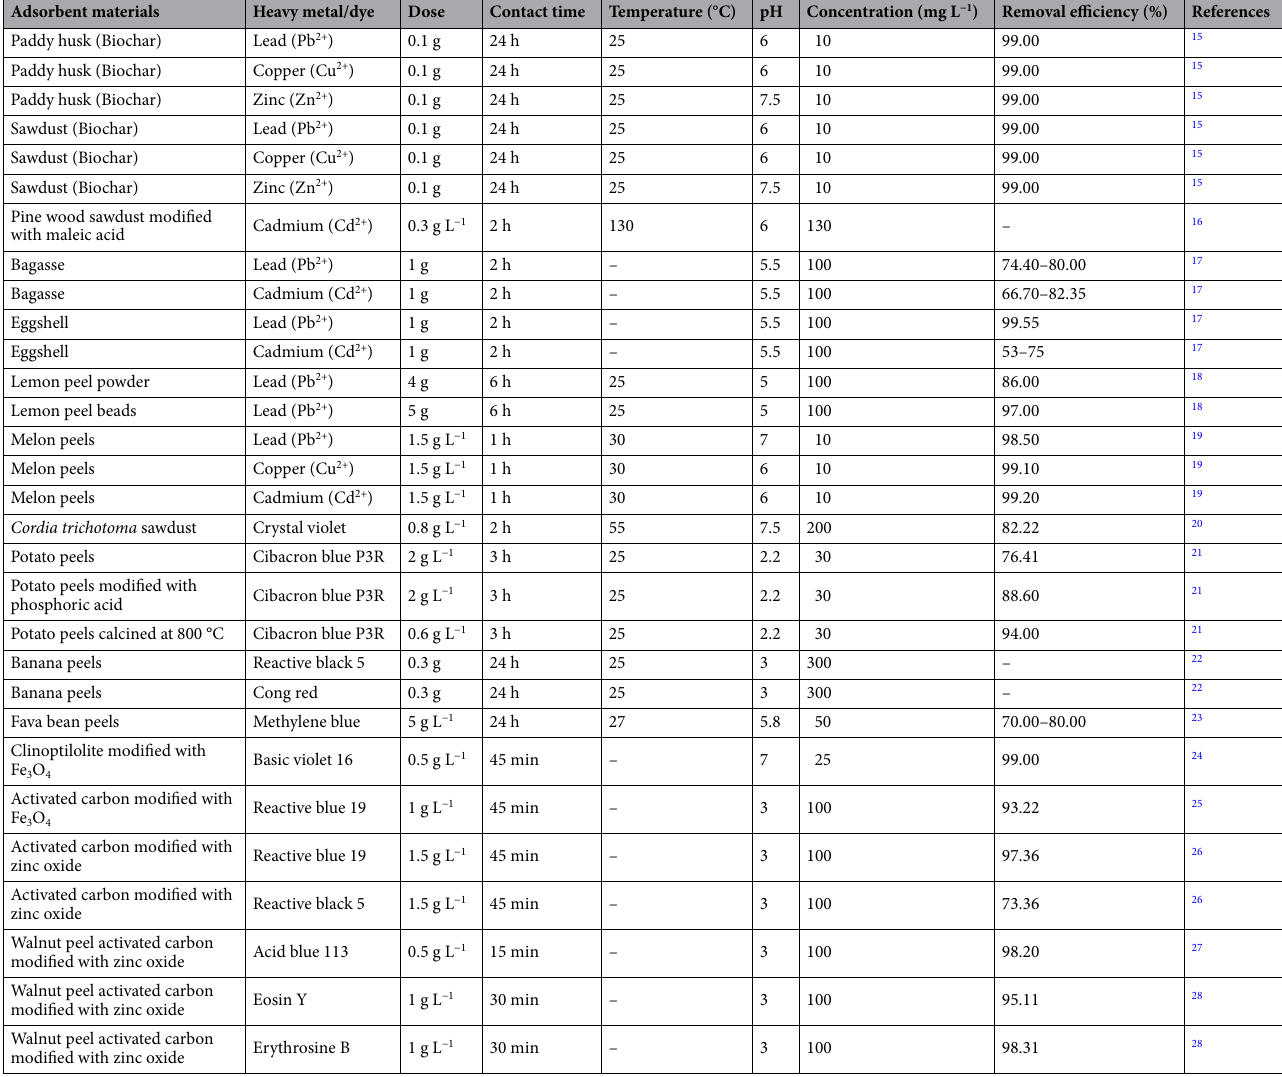
Table 1. The elimination of heavy metals or dyes from wastewater from various industrial